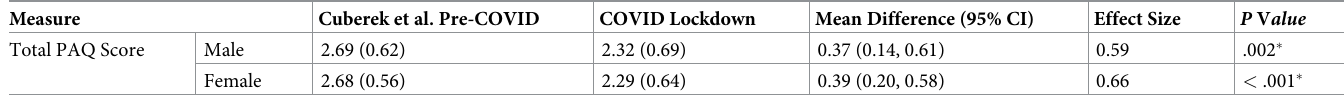
Table 3. Gender specific scores on the PAQ-C before and during COVID pandemic mean [standard deviation]).